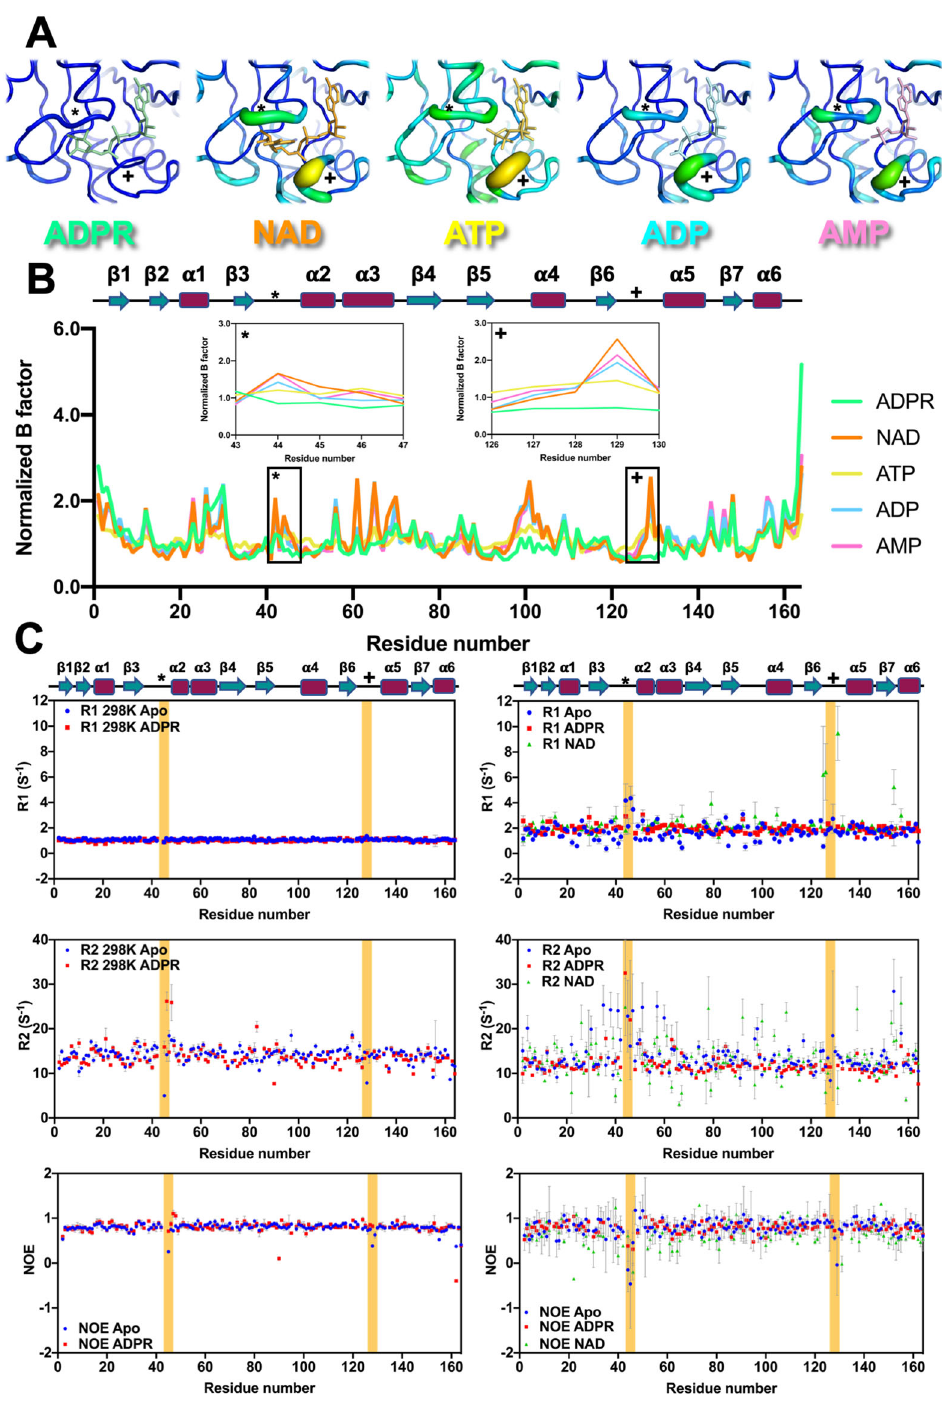
Fig. 7 A tunable ligand-binding site of the MERS-CoV macro domain. A Ligand binding site of MERS-CoV macro domain complexed with different NAD metabolites colored according to the B-factor putty script distributed with PyMOL. Distinguished loops are labeled by symbols, stars (*), and crosses ( + ). B Comparison of normalized B factor among various NAD metabolite-bound forms of the MERS-CoV macro domain. The fl exibility difference at the distinguished loops of the ligand-binding site (*, + ) is shown by insert plots of normalized B factor vs. residue number. C NMR relaxation parameters, R 1 , R 2 , NOE, of the MERS-CoV macro domain apo form, ADPR-complex, and NAD-complex form labeled by blue circles, red squares, and green triangles, respectively. The left and right panel show relaxation parameters determined at 298 K and 308 K, respectively. Parts of distinguished loops (*, + ) are colored in